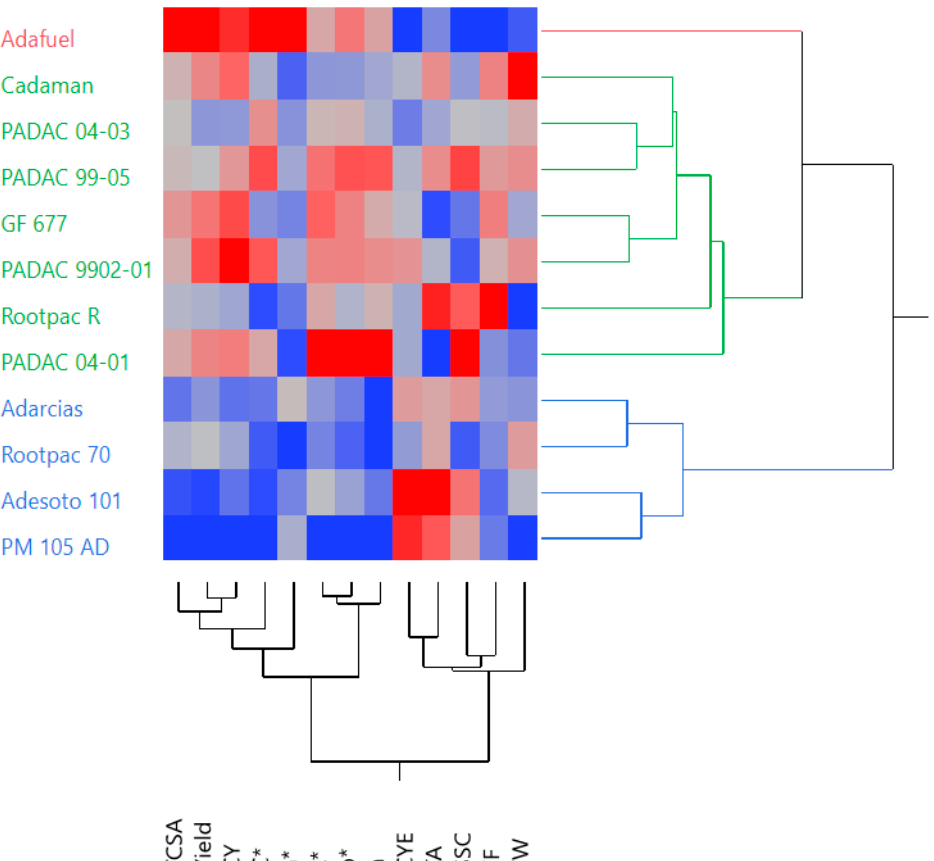
Figure 3. Hierarchical agglomerative cluster analysis grouped for the different rootstocks based on agronomical and fruit quality traits. Abbreviations: TCSA, trunk cross-sectional area; CY, cumulative yield; L*, a*, b*, C*, and h color parameters; CYE, cumulative yield efficiency; TA, titratable acidity; SSC, soluble solids content; FF, flesh firmness; FW, fruit weight. Higher trait values are red whereas lower means are blue and average values are gray. Rootstocks labeled in red belong to Cluster 1, labeled in green to Cluster 2, and labeled in blue to Cluster 3. CY, CYE and TCSA data is from 2017; FF, FW, SSC and TA data is 2013–2017 average, and L*, a*, b*, C* and h data is 2013–2016 average.